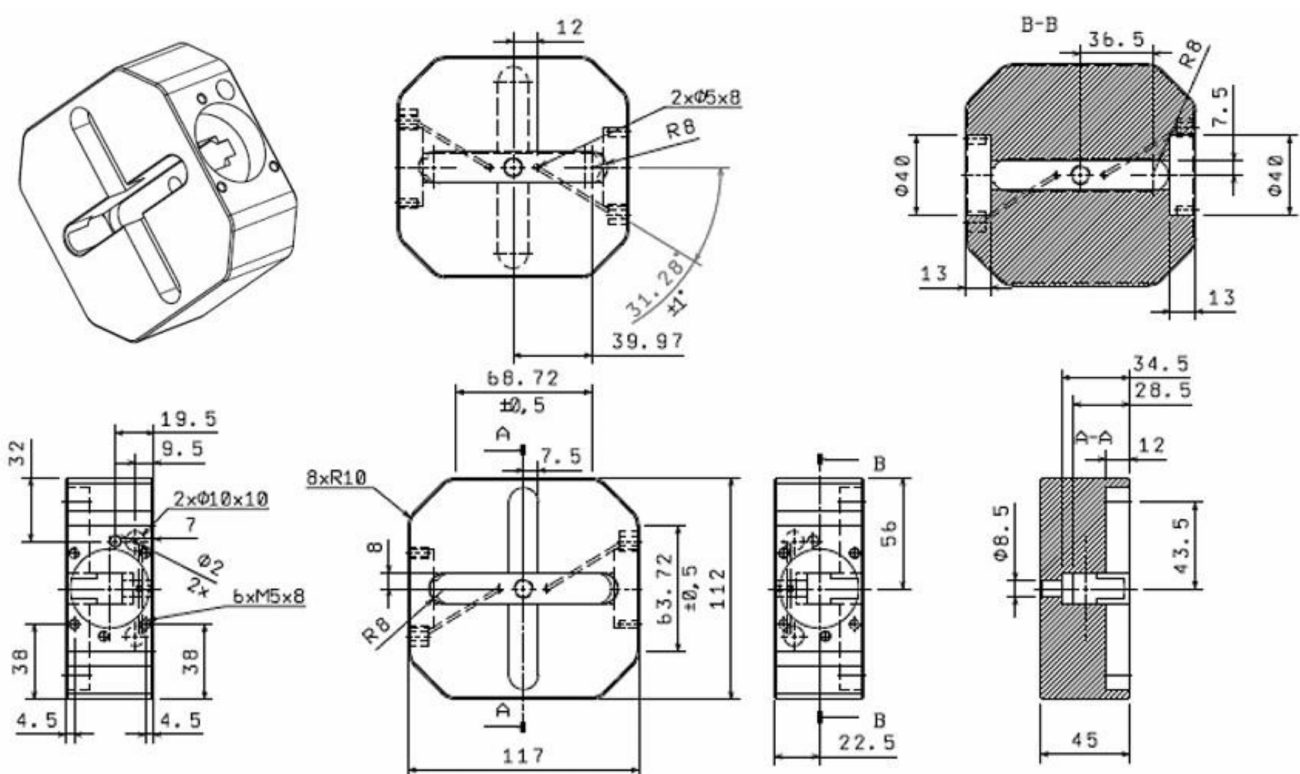
Figure 3. Exact board geometry used to build a real engine prototype to verify its functionality.